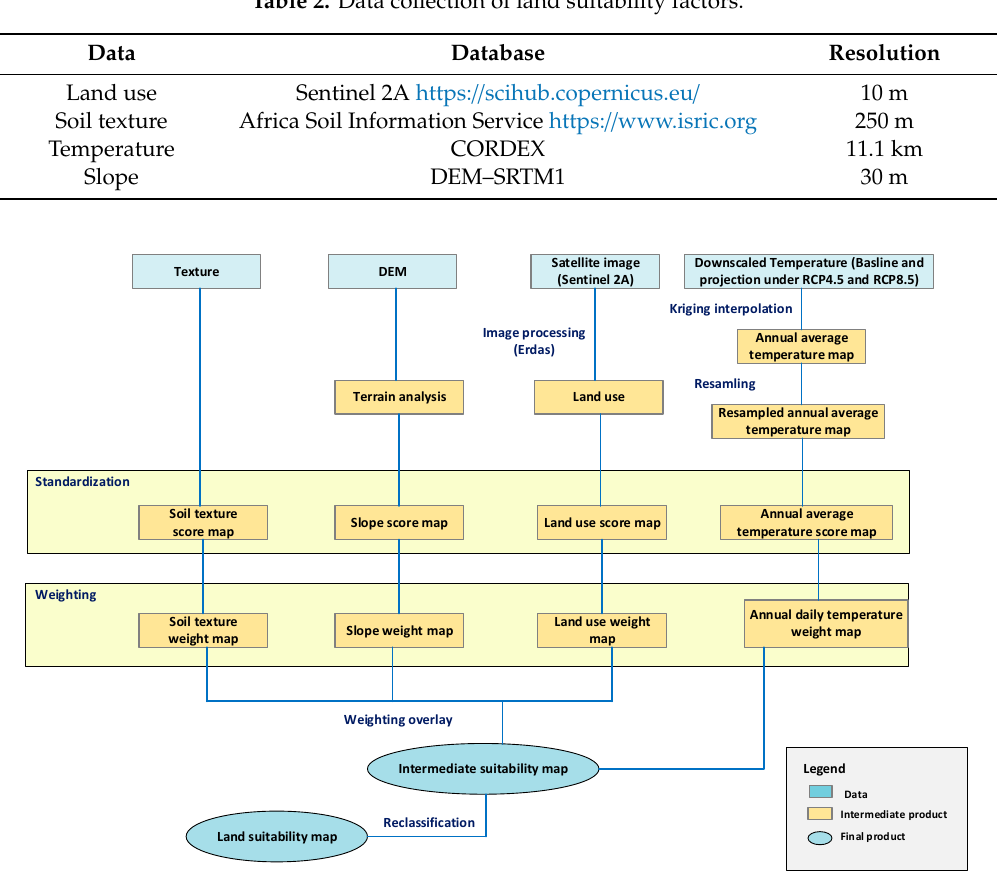
Figure 4. GIS-based (Geographic Information System) multiple criteria decision making (MCDM) methodology for land suitability analysis.